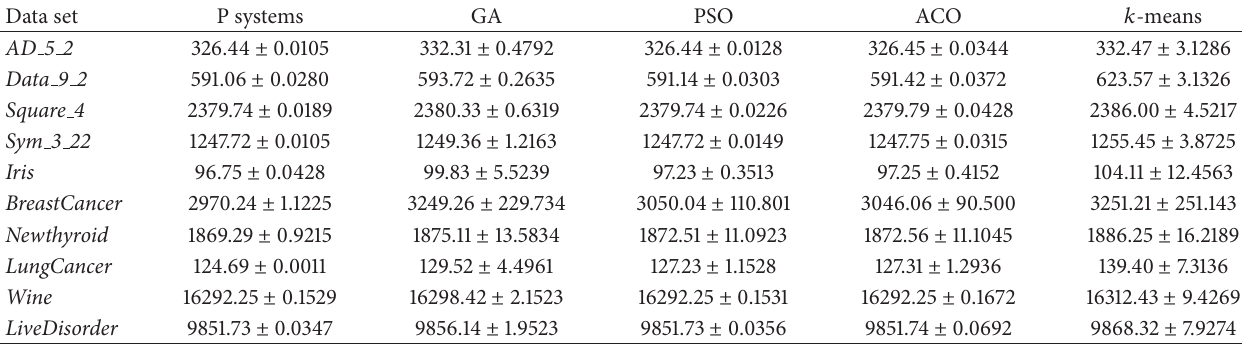
Table 3: The results obtained by the algorithms for 50 runs on the ten data